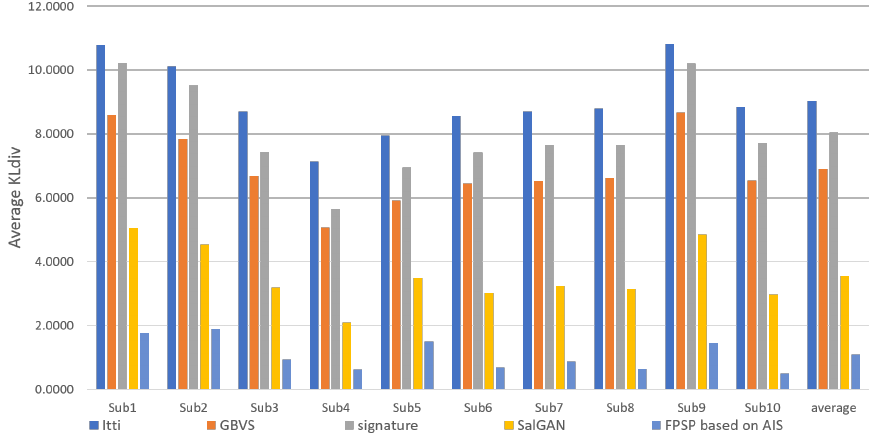
Figure 8. Average KLdiv of each target person ( ↓ ) with comparison to USM prediction methods.